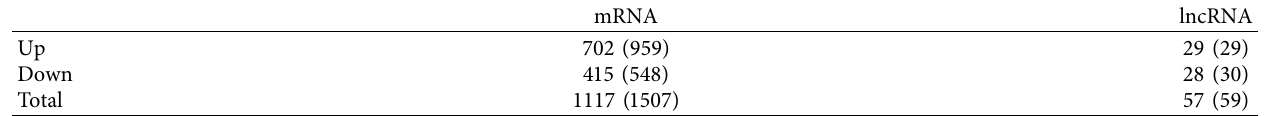
Table 1: Statistics of number of differentially expressed genes